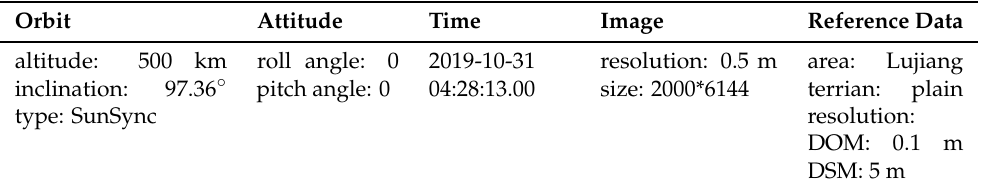
Table 2. Simulation parameters of high-resolution optical remote sensing images.